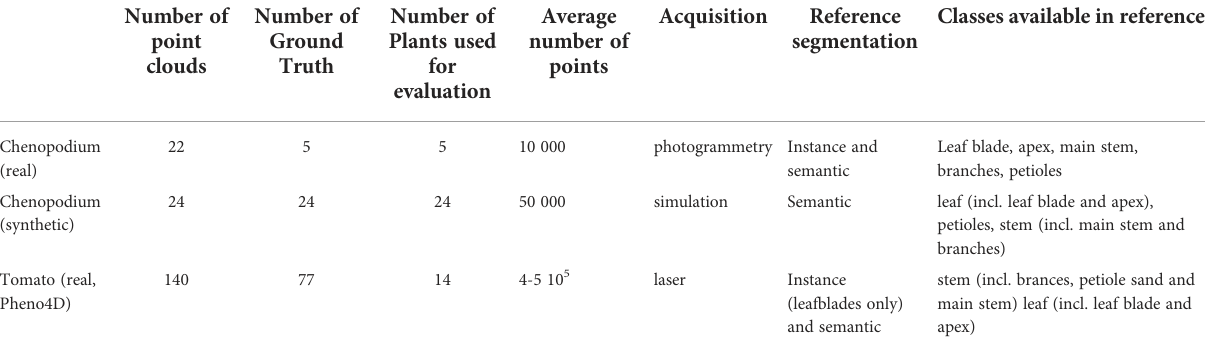
TABLE 1 Main characteristics of the plant data sets used to evaluate our